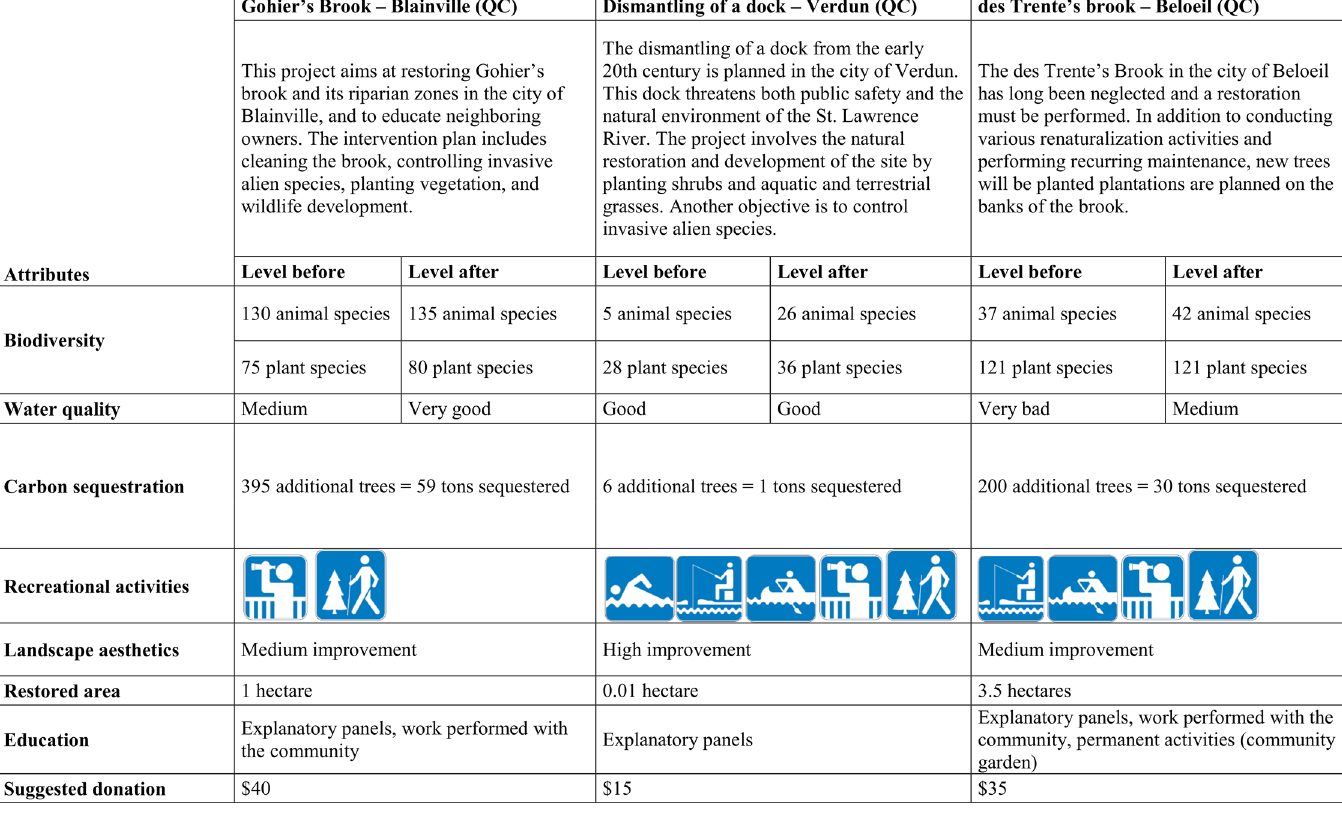
Fig 3. Scenarios presented to respondents in the contingent choice